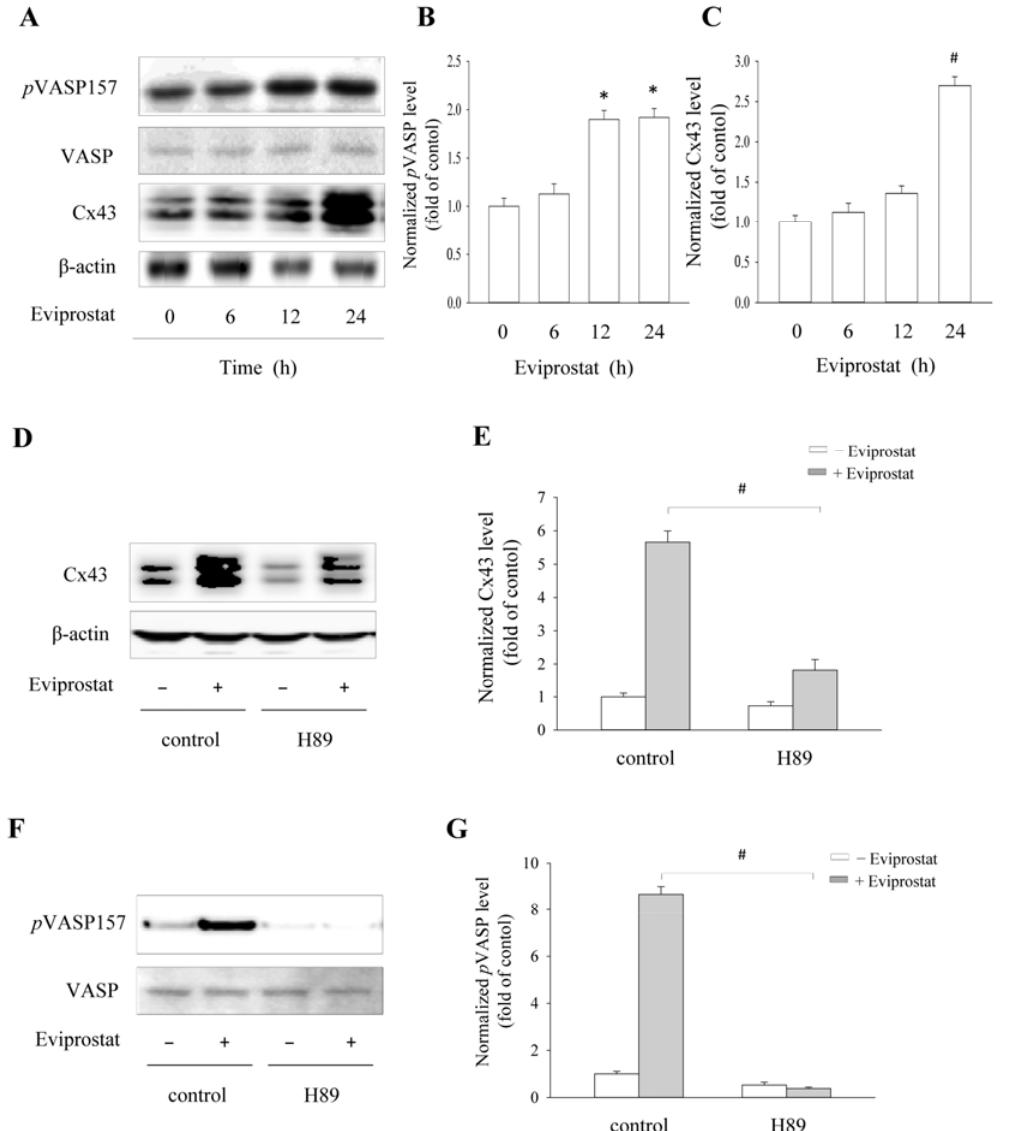
Figure 6. Activation of cAMP signaling pathway and induction of Cx43 by Eviprostat in BSMCs. ( A ) Time-dependent effects of Eviprostat on p VASP and Cx43. BSMCs were exposed to 50 μ g/mL Eviprostat or 0.1% dimethylsulfoxide as vehicle control for the indicated duration. Cellular protein was extracted and subjected to Western blot analysis using specific antibodies for p VASP and Cx43. Equal loading of protein per lane was verified by reprobing the blot with non-phosphorylated VASP and β -actin antibody. ( B , C ) Densitometric analysis of p VASP and Cx43 in A. The results were normalized to corresponding internal controls, and data were presented as induction relative to the basal level in control. # p < 0.01, * p < 0.05. ( D – G ) Effect of PKA inhibitor on Cx43 levels and VASP phosphorylation induced by Eviprostat. BSMCs were pretreated with 10 μ M H89 for 30 min before exposing to 50 μ g/mL Eviprostat for an additional 24 h. The levels of Cx43 and pVASP were determined by Western blot analysis, and non-phosphorylated VASP and β -actin were used as internal control. Densitometric analysis of Cx43 and pVASP level in D and F were shown in E and G, respectively. # p <